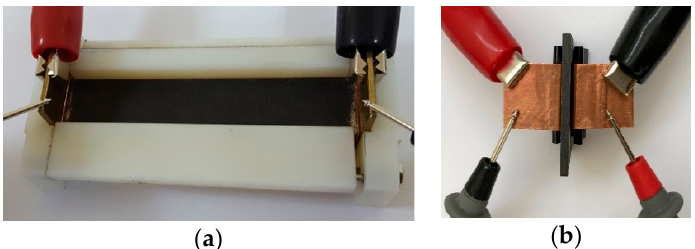
Figure 1. ( a ) The electrical resistivity test along the X axis; ( b ) the electrical resistivity test along the Z axis.